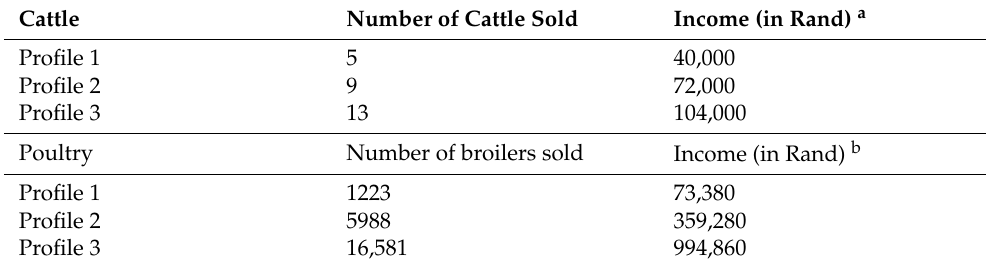
Table 9. Expected income of farmers by different profiles.